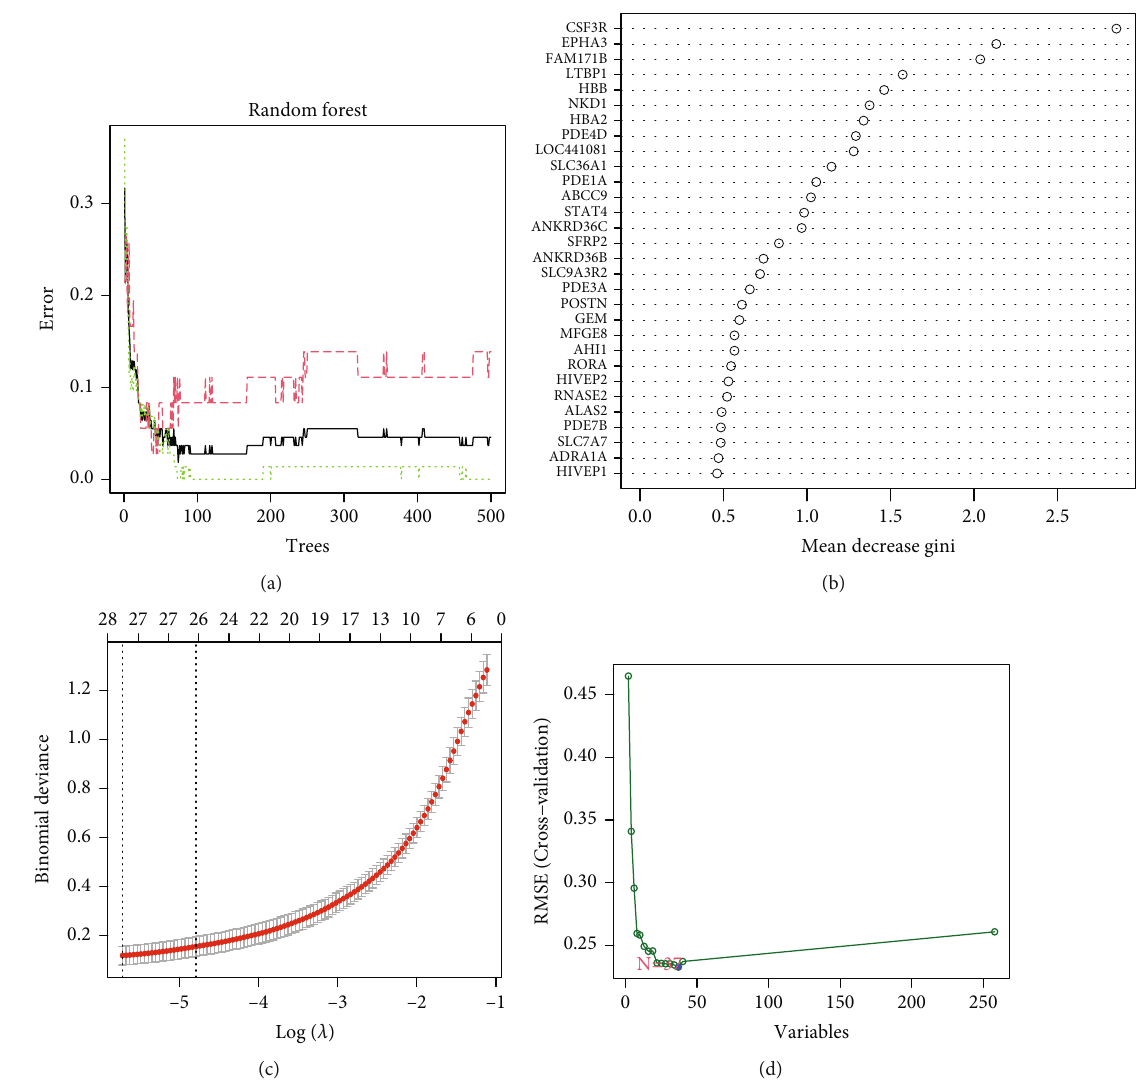
Figure 7: Construct multiple machine learning models based expression of DEGs. (a) The e ff ect of the decision tree number on the error rate. The x -axis denotes the number of decision trees, while the y -axis shows the error rate. When approximately 100 decision trees are used, the error rate is generally steady. (b) The results of Gini coe ffi cient method in a random forest classi fi er. The x -axis displays the genetic variable, and the y -axis the signi fi cance index. (c) Fine-tuning the least absolute shrinkage and selection operator (LASSO) model ’ s feature selection. LASSO regression was used to narrow down the DEGs, resulting in the discovery of 28 variables as potential markers for PAH. The ordinate represents the value of the coe ffi cient, the lower abscissa represents log( λ ), and the upper abscissa represents the current number of nonzero coe ffi cients in the model. (d) A plot illustrating the process of selecting biomarkers using the support vector machine-recursive feature elimination (SVM-RFE) technique. The SVM-RFE technique was used to identify a subset of 37 characteristics from the DEGs. DEGs: di ff erentially expressed genes; PAH: pulmonary arterial